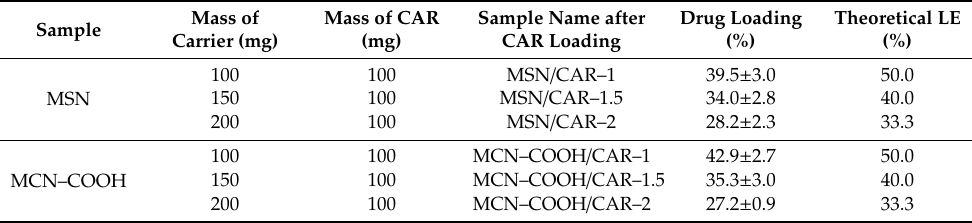
Table 2. The loading e ffi ciencies of CAR loaded samples using solvent evaporation